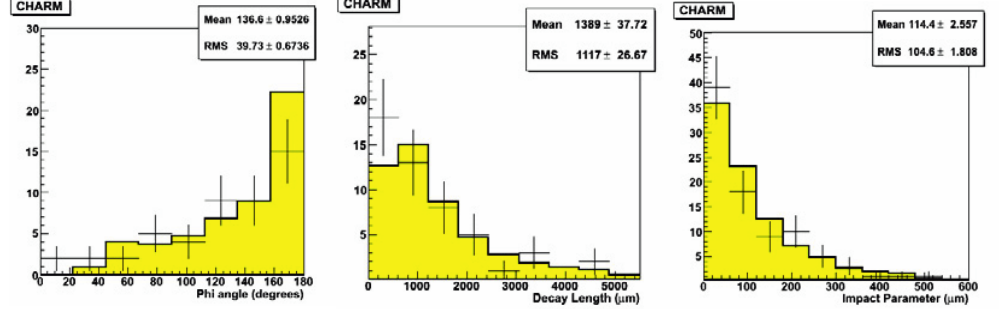
Figure 2. From left to right, experimental data (black error bars) superimposed to Monte Carlo data (yellow histogram): a) Distribution of the angle φ between the primary muon and the hadronic system in the transverse plane. b) Distribution of the decay length of the charmed meson. c) Distribution of the impact parameter of the charmed meson with respect to the primary